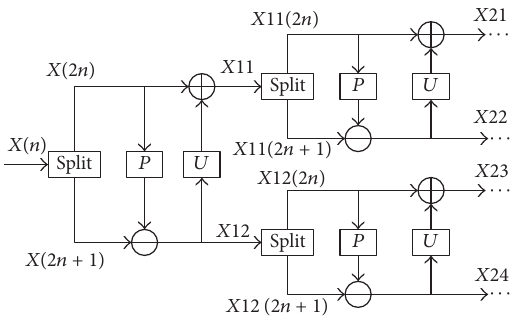
Figure 1: Block diagram of the forward transform of